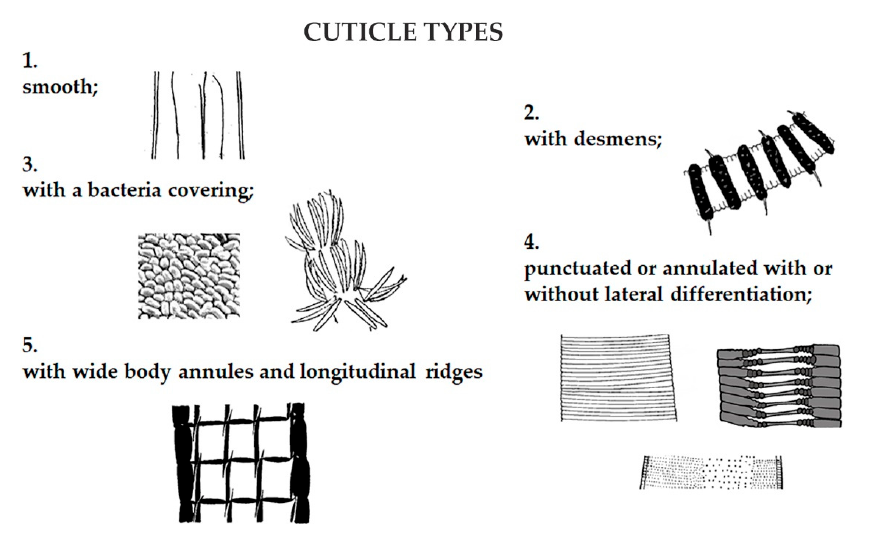
Figure 3. Cuticle has a role in defense against predators, pollution, and hydrodynamic energy and in nematode locomotion. Five categories of cuticles were recognized on the base of their morphol- ogy and thickness. and